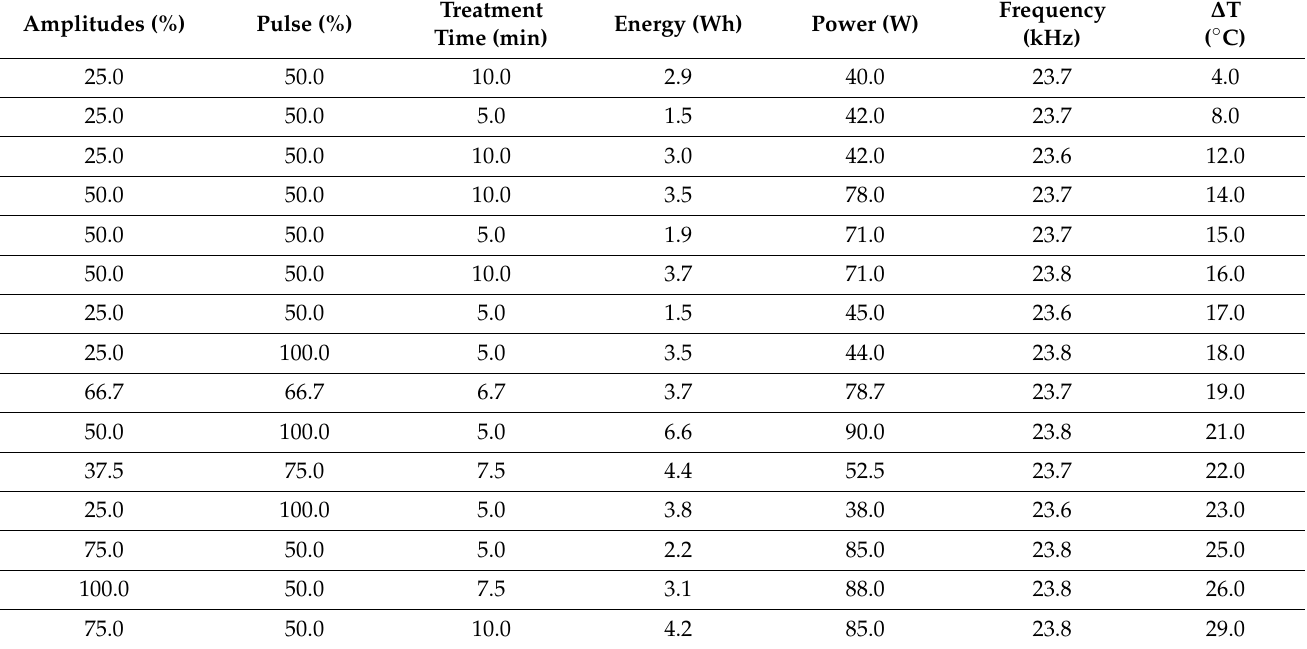
Table 5. HPU treatment